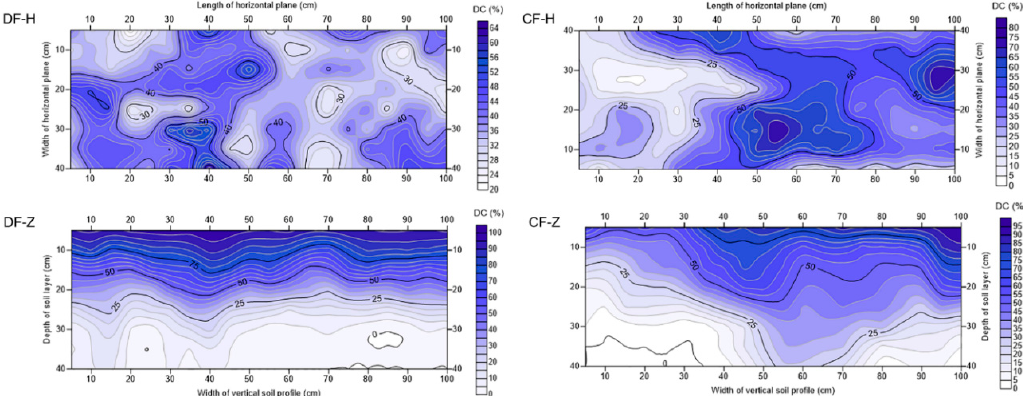
Figure 3. Spatial distribution of dye coverage (DC (%)). DF-H and CF-H are the horizontal spatial distribution of dye coverage in DF and CF, respectively; DF-Z and CF-Z are the vertical spatial distribution of dye coverage in DF and CF, respectively. DF: deciduous forest; CF: coniferous forest.